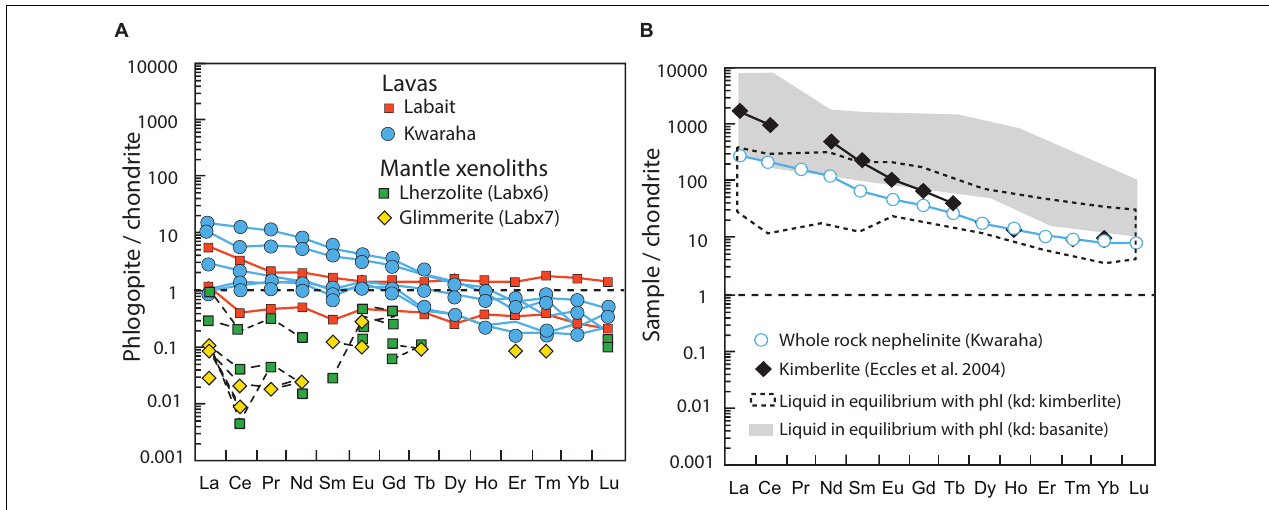
FIGURE 7 | (A) Chondrite-normalized REE patterns of phlogopite from Kwaraha and Labait lavas and lherzolite (Labx6) and glimmerite xenoliths (Labx7). (B) Representative chondrite-normalized whole-rock REE pattern of Kwaraha lavas, and the silicate liquids in equilibrium with phlogopite (phl) calculated using partition coefficients for kimberlite (Fujimaki et al., 1984) and basanite (Adam and Green, 2006). The chondrite-normalized REE pattern of kimberlite (Eccles et al., 2004) is shown for comparison with the calculated liquids. Chondrite and primitive mantle values from Sun and McDonough (1989).